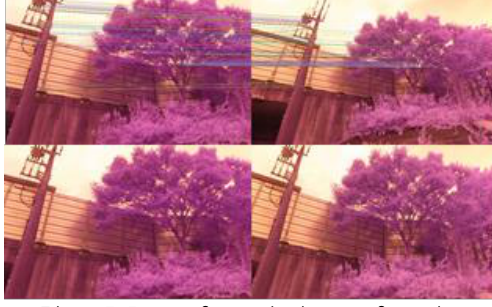
Figure 11. DN values on green band